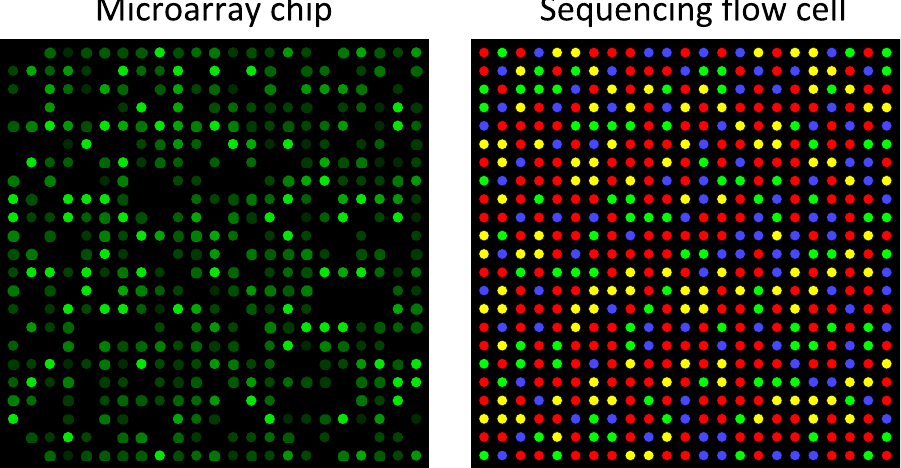
Fig 5. Microarray and sequencing flow cell. Microarrays and RNA sequencing (RNA-Seq) rely on image analysisin different ways. In a microarray chip, each spot on a chip is a definedoligonucleotide probe, and fluorescence intensity directly detects the abundance of a specific sequence(Affymetrix, Santa Clara, CA). In a high-throughput sequencing flow cell, spots are sequencedone nucleotide at a time, with the colour at each round indicating the next nucleotide in the sequence(IlluminaHiseq, San Diego, CA). Other variations of these techniques use more or fewer colour